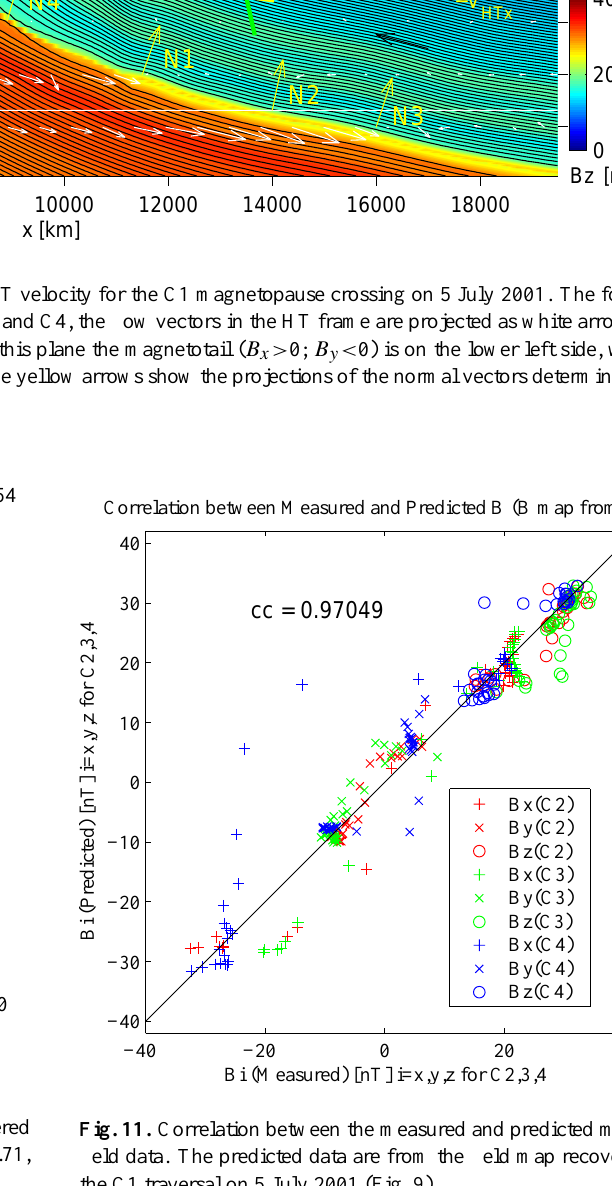
Fig. 11. Correlation between the measured and predicted magnetic field data. The predicted data are from the field map recovered for the C1 traversal on 5 July 2001 (Fig.